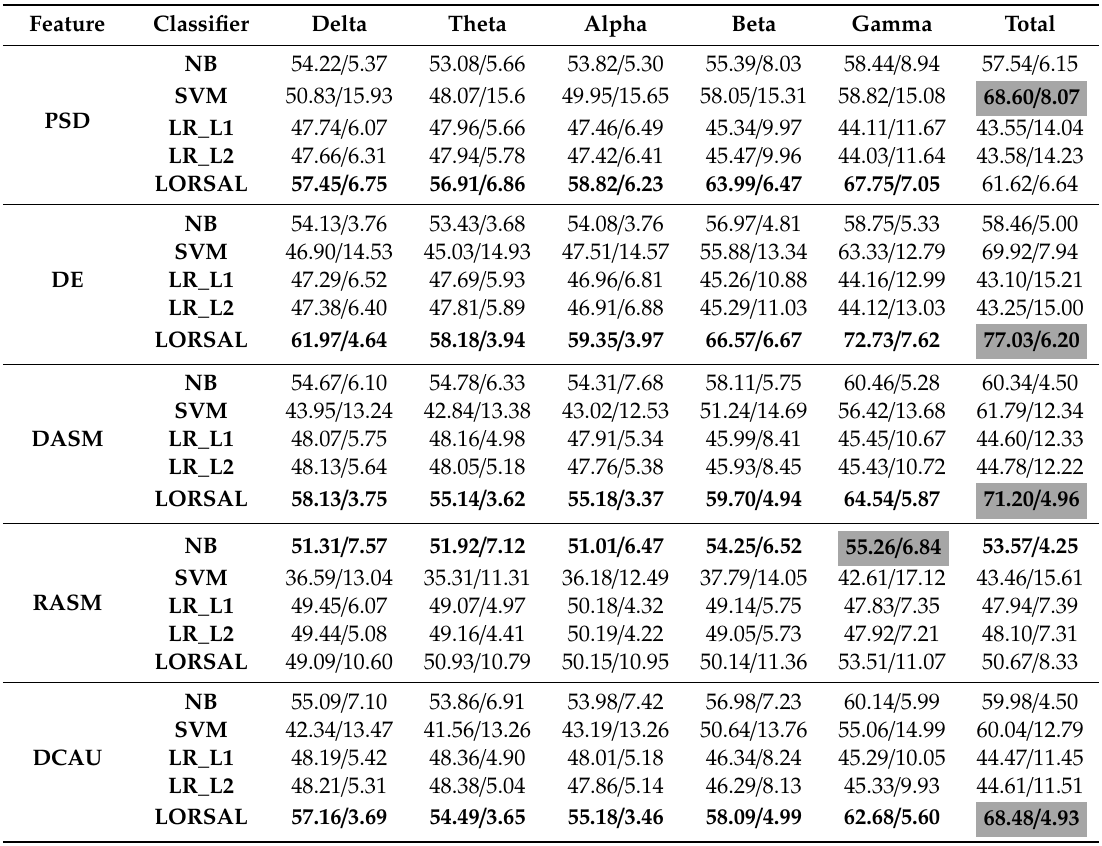
Table 2. The mean precisions and standard deviations (%) of the classification of LA / HA emotions obtained by the compared classifiers for di ff erent features extracted from di ff erent frequency bands.